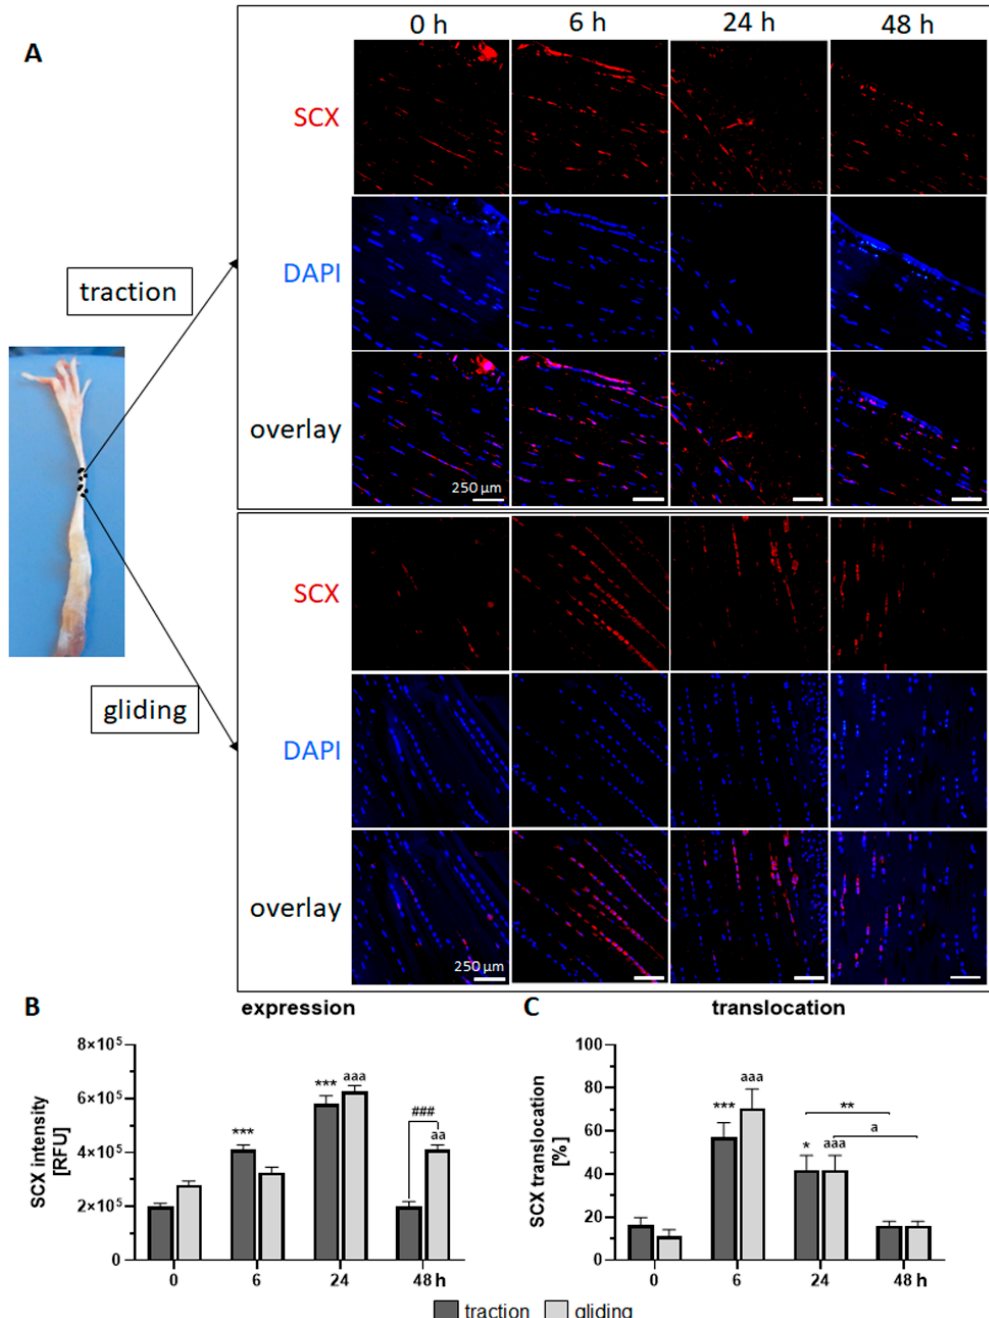
Figure 3. Effects of uniaxial treatment on scleraxis (Scx) expression and translocation in the traction and gliding areas of tendon. ( A ) Representative immunofluorescence-stained sections of Scx (red), DAPI (blue, nuclear staining), and a representative overlay where these tendons are located (left panel). ( B ) The application of uniaxial force increased Scx protein expression during the first 24 h in the traction region, which then returned to the basal level. In the gliding tendon, Scx expression was delayed but also peaked at 24 h before returning to basal levels. Note that after 48 h, Scx expression was higher in the gliding tendon. ( C ) Scx translocation into the nucleus occurred during the first 6 h, followed by a steady return to basal levels. The p -values are given as p ≤ 0.05, p ≤ 0.01, and p ≤ 0.001. Asterisks indicating statistical differences in comparison to the 0 h control time point within the traction group, letters indicate statistical difference in comparison to the control time point within the gliding group, and hashtags indicate traction vs. gliding within the different time points.